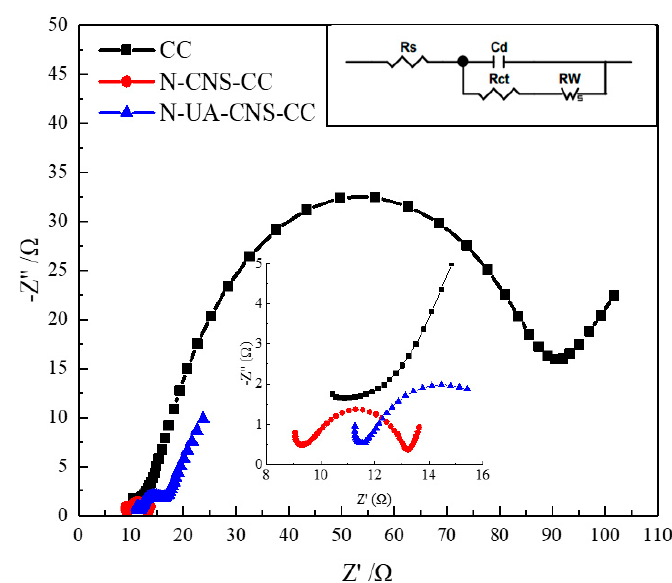
Figure 4. Nyquist plots of CC, the self-doped-nitrogen porous carbon nanosheets(N-CNS)-CC and the unactivated self-doped-nitrogen porous carbon nanosheets(N-UA-CNS)-CC anode, the inset is the equivalent circuit.